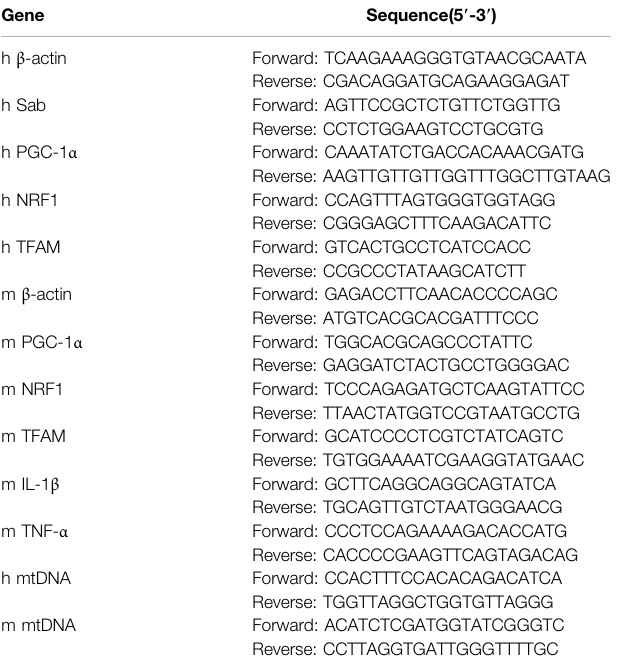
TABLE 1 | The sequences of primers used in PCR.